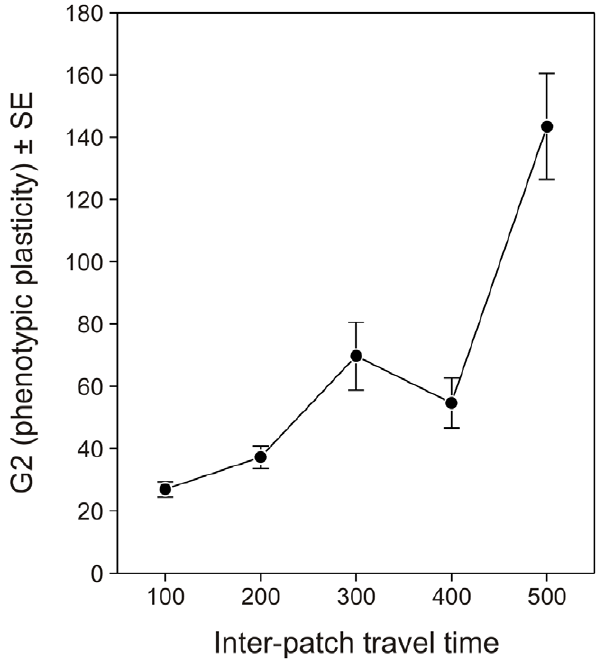
Figure 6. Effect of inter-patch travel time on the optimized values of the parameter G2. Average ( 6 SE) optimized values of G2 defining the range of phenotypic plasticity (see Figure 1) for parasitoid females spending different times to travel between habitat patches.